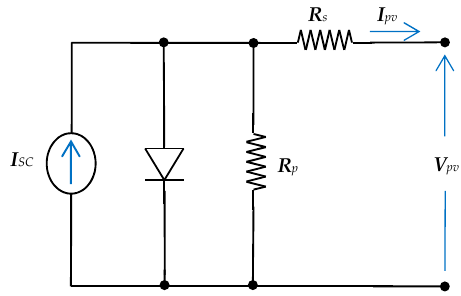
Figure 2. Model of the PV panel, where I SC is the panel short circuit current and ( R p , R s ) is the model parallel and series resistances.